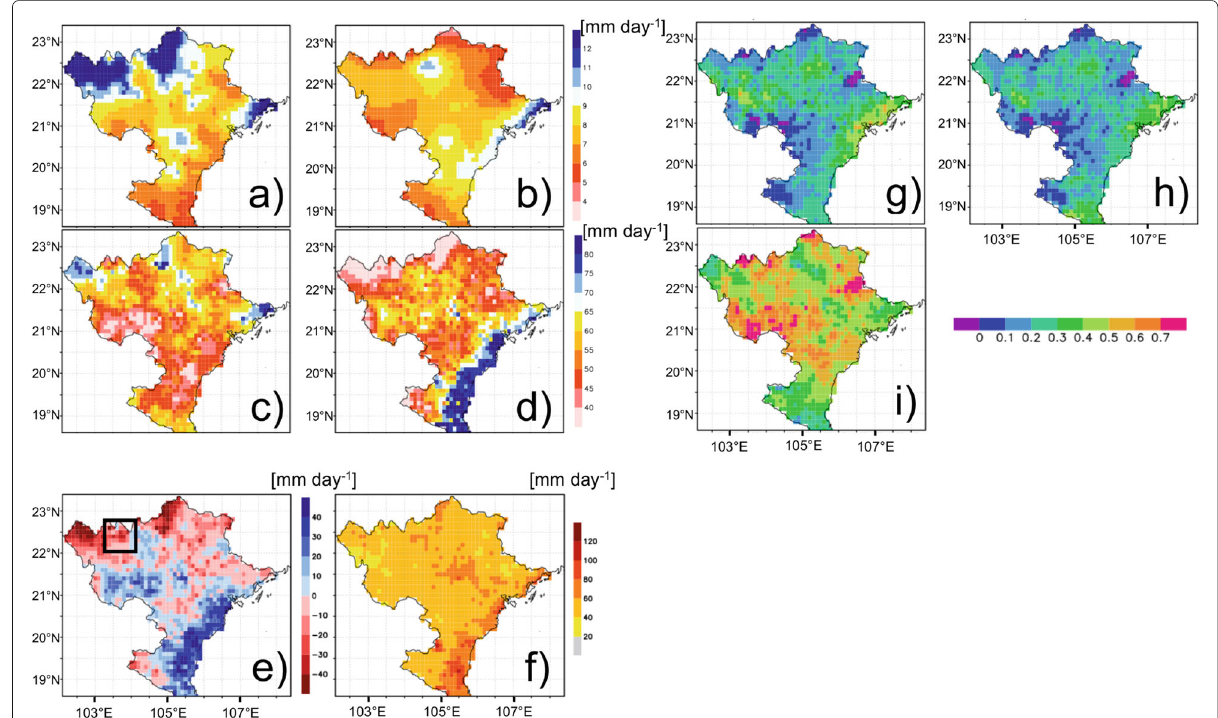
Fig. 3 Distributions of climatological daily precipitation, for heavy-rain days, and its reproducibility by GSMaP over the period of May–Aug., from 2001 to 2010. Daily mean precipitation is shown in a VnGP and b GSMaP, for all the analyzed days, and in c VnGP and d GSMaP, for heavy-rain days, defined as days with precipitation exceeding 50 mm day − 1 in at least one dataset out of VnGP or GSMaP, for each grid. Performance of GSMaP on the heavy-rain days shown by e biases were calculated as mean daily precipitation in GSMaP ( d ), minus that in VnGP ( c ), and f the root mean square difference between GSMaP and VnGP. Categorized forecasts for precipitation exceeding 50 mm day − 1 were verified with g probability of detection, h false alarm ratio, and i equitable threat score. The black rectangle in e shows the region analyzed in Fig.